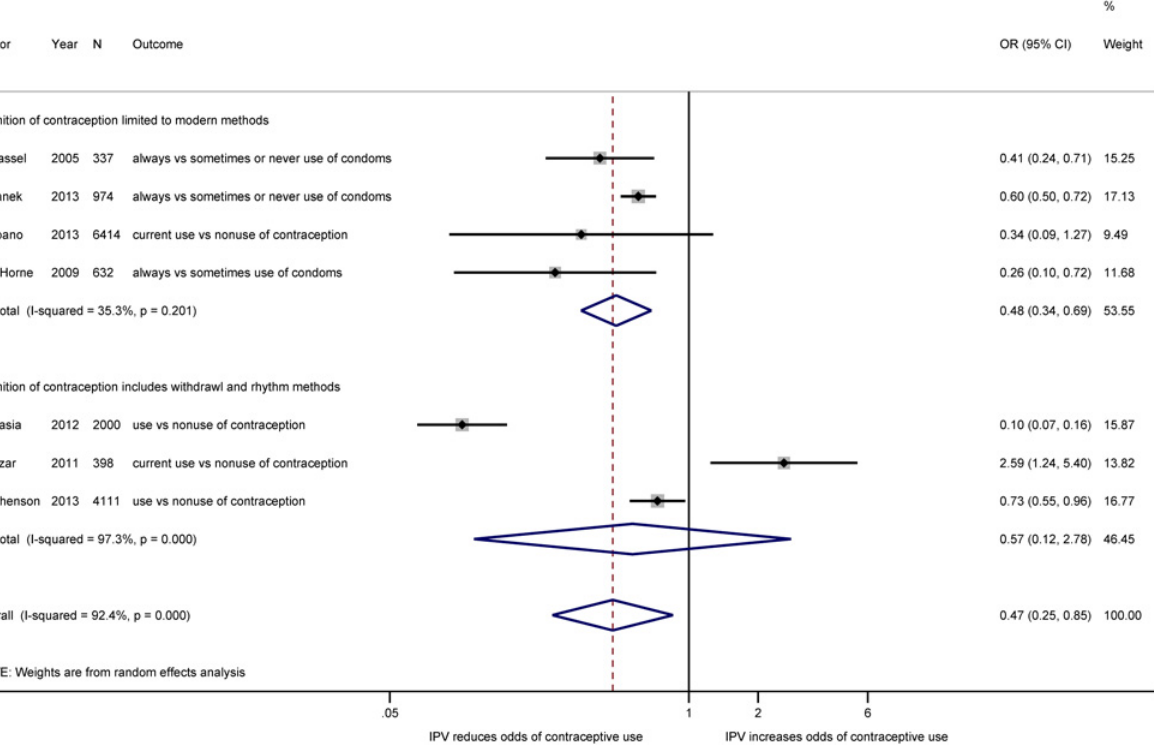
Fig 4. Meta-analysis of the association between IPV and contraceptive use, by definition of FP. Estimated effect measures from the Fantasia, Kacanek, and Van Horne studies have been inverted to present estimates of contraceptive use rather than